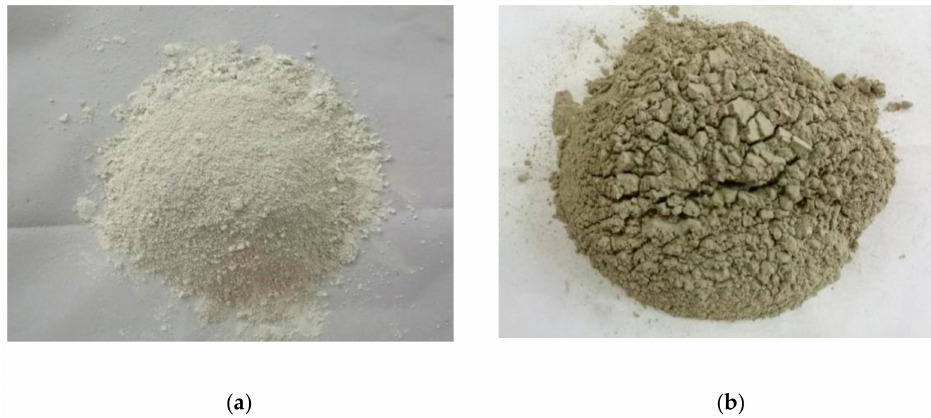
Figure 2. Macro morphology of mineral admixtures. ( a ) Metakaolin, ( b ) Superfine fly ash.